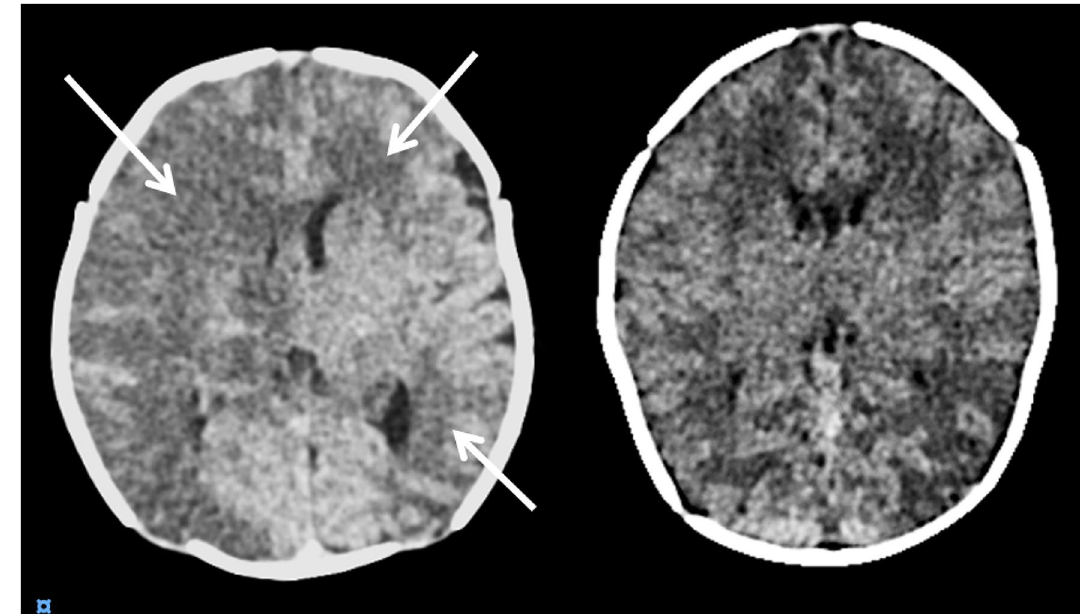
Figure 2. Examples of computed tomography scans of patients who developed brain infarctions during ECMO treatment. The left panel shows an almost complete right-sided thromboembolic infarction in the right middle cerebral artery territory and a smaller infarction in the left frontal and lateral occipital lobe. The right panel shows a deep brain infarction caused by hypoperfusion injury and/or possibly posterior reversible encephalopathy